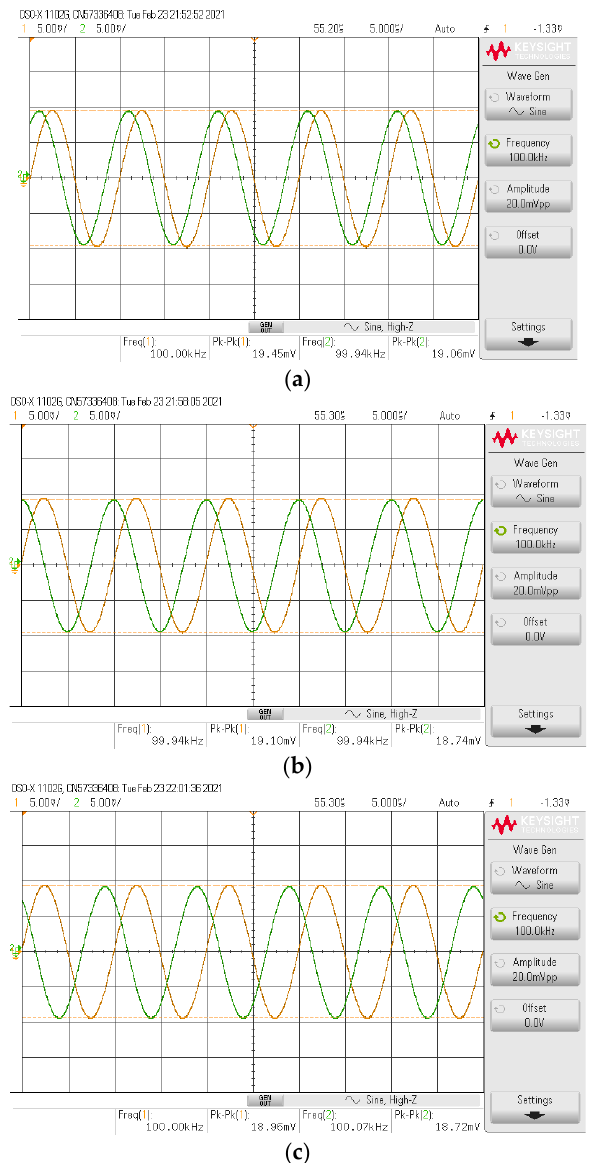
Figure 21. Measured input and output waveform of AP ‐ ( ‐‐‐‐ v in , ‐‐‐‐‐ v o ). ( a ) I B = 67 μ A. ( b ) I B = 124.5 μ A. ( c ) I B = 245 μ A.